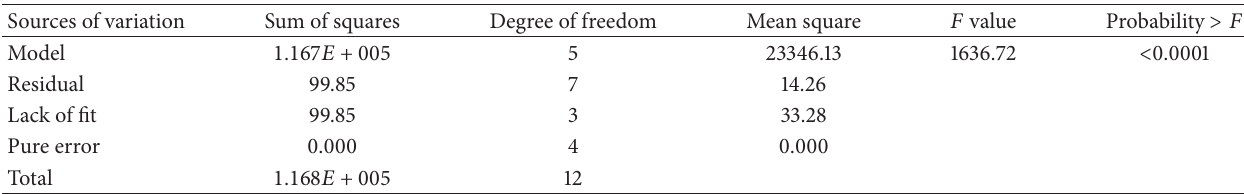
Table 8: Analysis of variance (ANOVA) for quadratic model for 𝑞 .